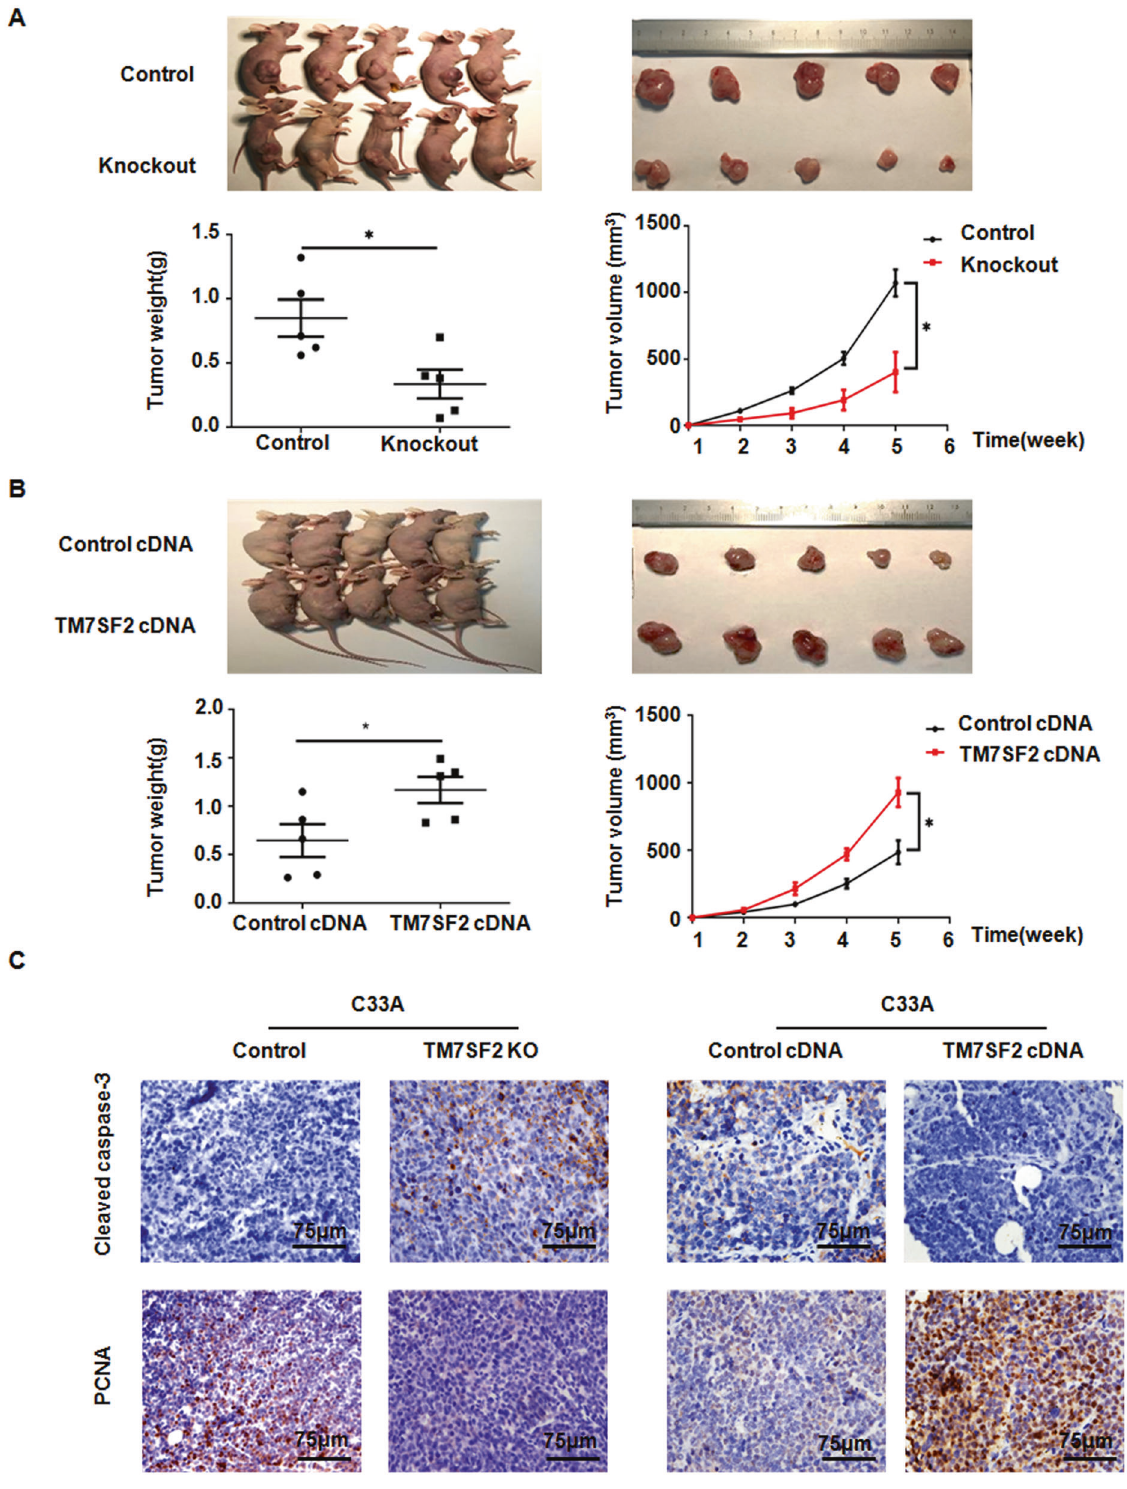
Fig. 7 TM7SF2 promotes the subcutaneous tumor growth in vivo. A , B Upper: the pictures of nude mice and xenografts were collected and photographed at the 35th day after subcutaneous injection of TM7SF2-overexpressing or TM7SF2-knockout C33A cells. Bottom: the weight of each tumor was measured and the tumor volume was calculated according to the formula (L × W 2 )/2. The data were showed as mean ± SEM. C The representative images for immunohistochemical staining of Cleaved caspase-3 and PCNA in C33A subcutaneous xenografts with TM7SF2-overexpressing or TM7SF2-knockout groups. * p < 0.05 compared to control.